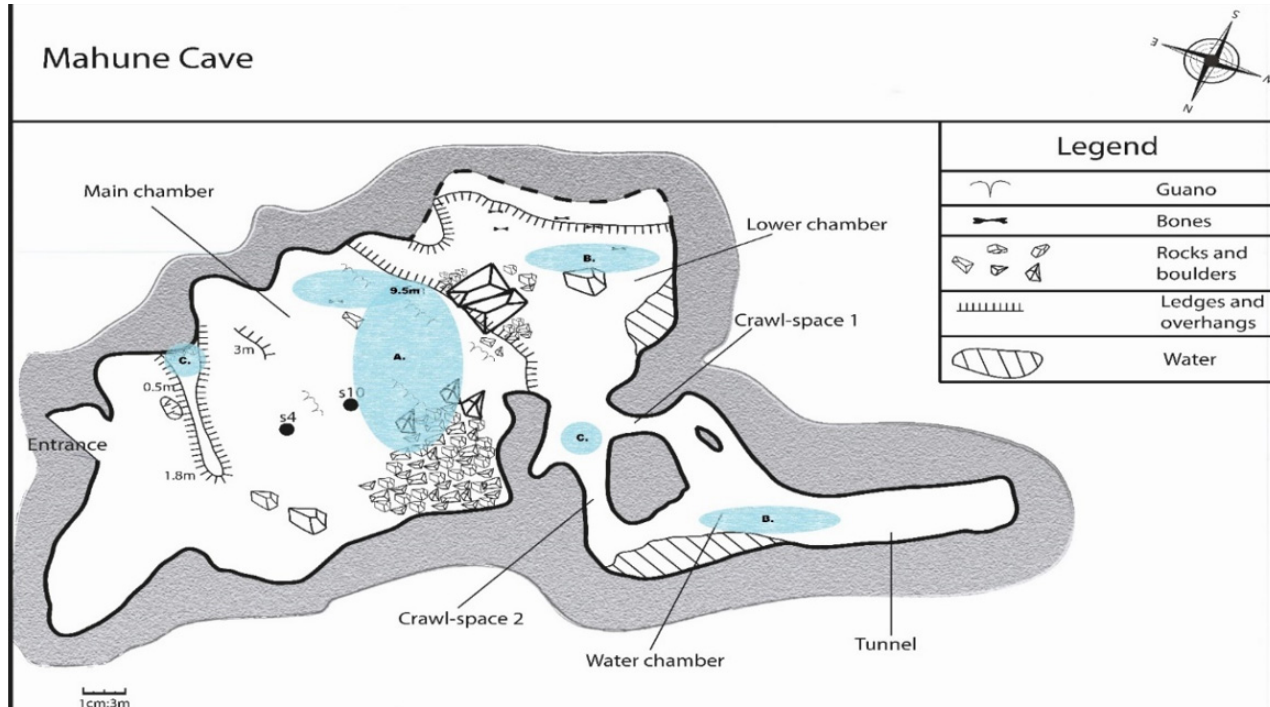
Figure 2. Transectional view of Matlapitsi cave system at a scale of 1 cm:3 m: Shaded area A. indicates the roosting area of Rousettus aegyptiacus in the main chamber of the cave. Shaded areas B. indicate the areas where Miniopterus natalensis , Myotis tricolor , and Hipposideros caffer roost when present. Shaded areas C. indicate the only areas that Nycteris thebaica and Rhinolophus spp. have been observed roosting.